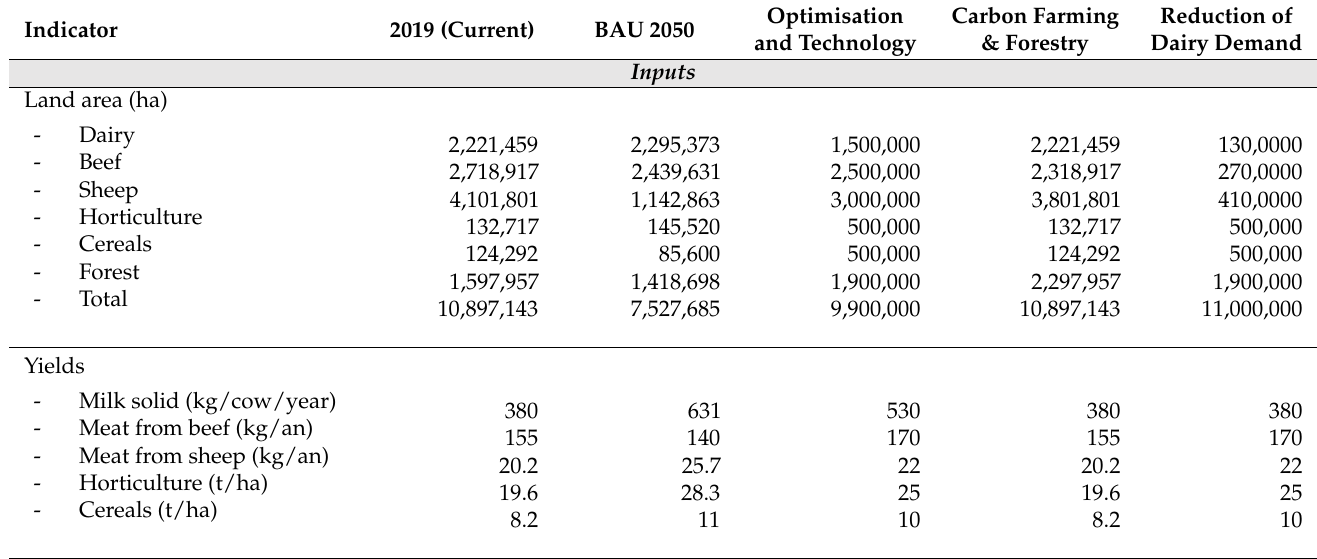
Table A1. Scenario inputs and indicators results. Scenario output values are highlighted in green when the targets (Table 4) are met and in red when the target is not